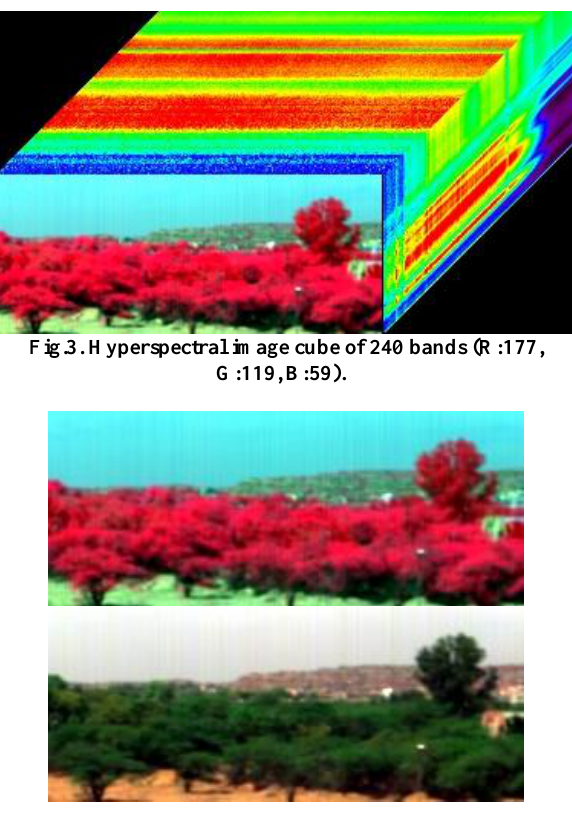
Fig.4. (a) FCC Composite Image (b) TCC Composite